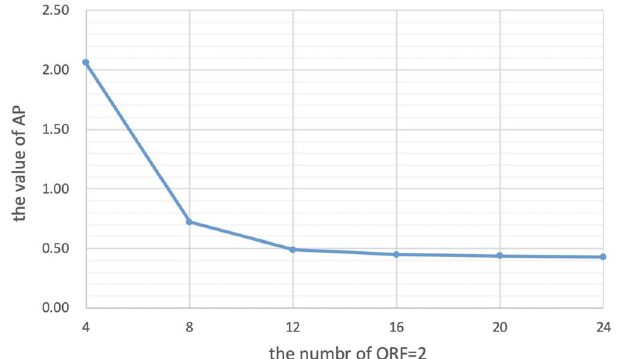
Figure 3. The impact of sampling different numbers of ORF = 2 data on the AP of the reconstruction result image.